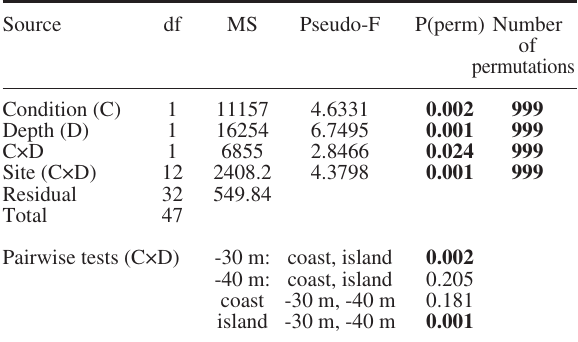
Fig . 2. – Map of the study area. Symbols indicate the sampling sites. Stars, small islands; triangles, continental coasts Table 1. – Results of PERMANOVA analysis. Significant results are in bold.